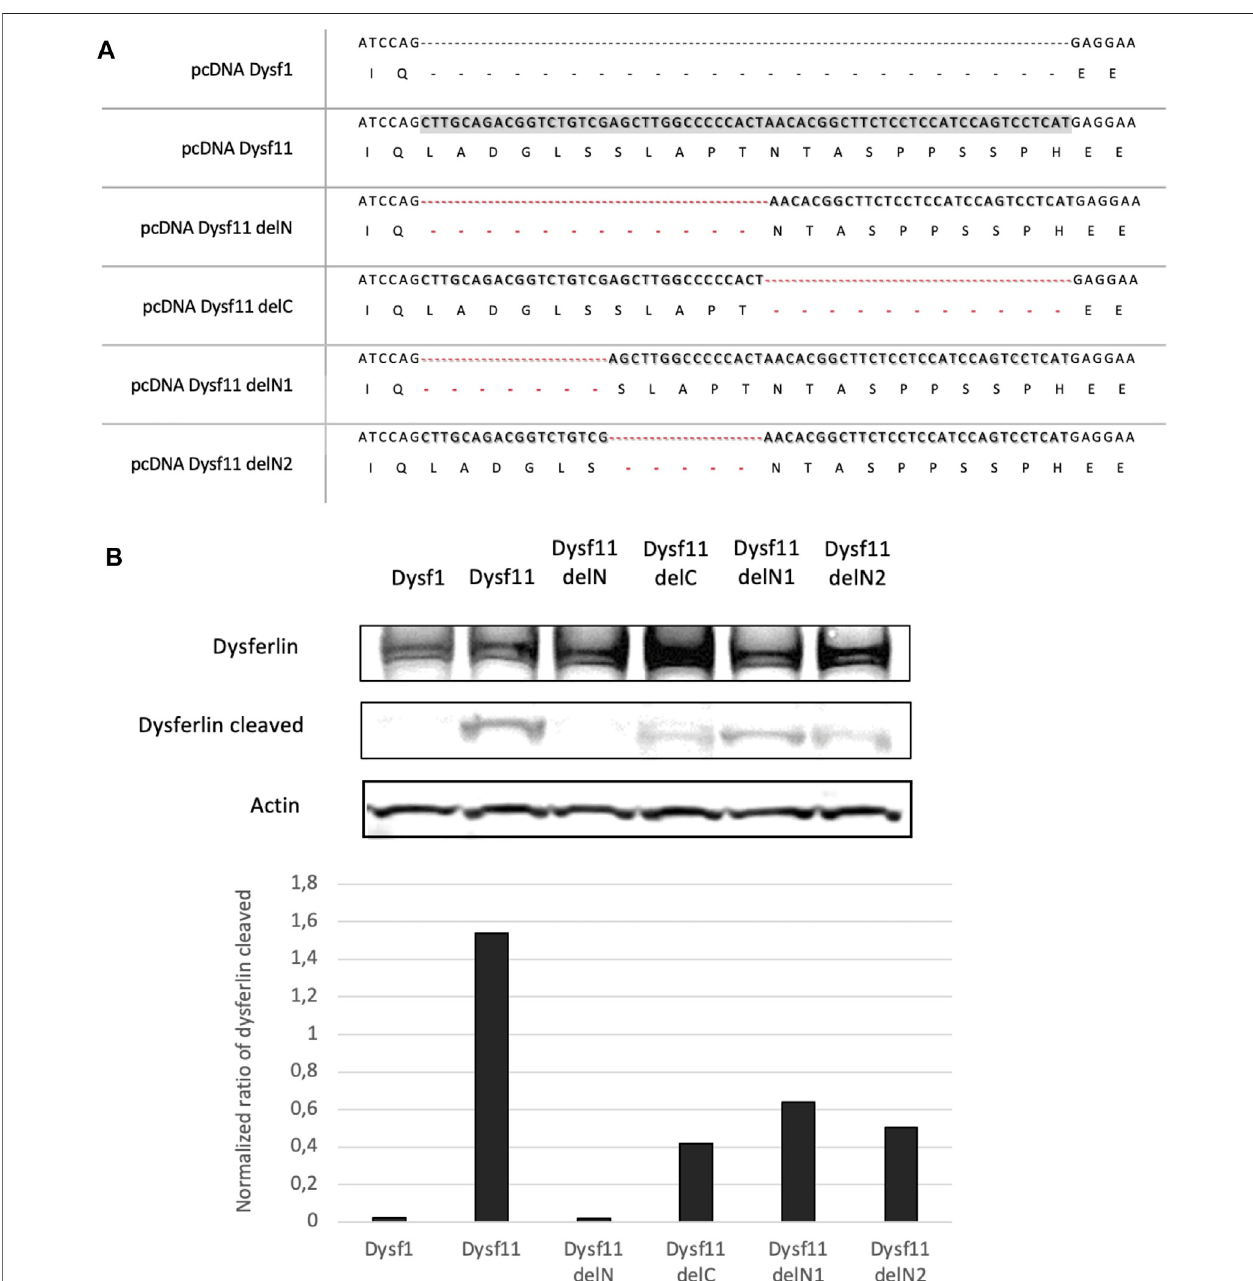
FIGURE2| TheN-terminalpartofDYSFexon40aisessentialforcalpaincleavage. (A) ASummaryofdysferlin11constructscreatedtoidentifycalpaincleavagesite in DYSF exon 40a. Constructs were built by PCR fusion. (B) Western-Blot performed with proteins from HEK cells transfected with dysferlin constructs and injured by ionomycin and cells scrapers 24 h post-transfection. Hamlet-1 was used to detect dysferlin and the cleaved dysferlin. Actin staining was used for normalization.